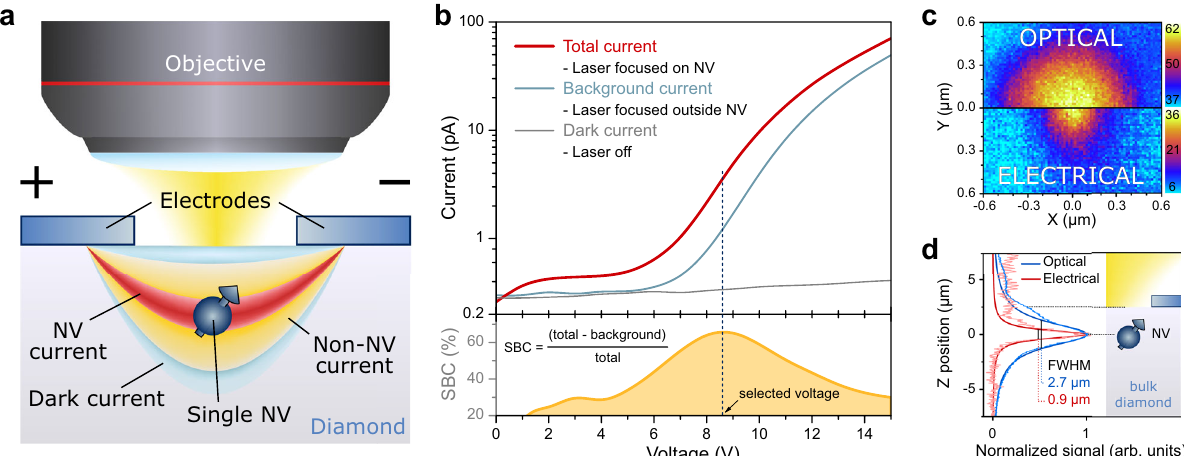
Fig. 1 Electrical detection of single NV centre. a Schematic of the PDMR chip with the single NV centre used for the measurements. A yellow-green 561 nm laser is focused between the contacts (with an inter-electrode distance of 3.5 µ m) using a microscope objective in air (N.A. = 0.95). The resulting currents are measured versus the bias voltage applied to the electrodes. We identify three types of currents: dark current — not related to the laser illumination, non-NV photocurrent — laser-induced photocurrent not originating from the NV centre, NV photocurrent — current from the two-photon ionization of the single NV centre. b Current – voltage characteristic curves for laser off (grey, dark current), for laser (4 mW) focused away from the single NV centre (cyan, background current from dark current and non-NV photocurrent) and for laser (4 mW) focused on the single NV centre (red, total current from dark current, non-NV photocurrent, and NV photocurrent). The bias voltage for the photocurrent measurements was set to 8.6 V as determined from the maximum signal-to-background contrast (SBC) calculated from the background and total current (dark yellow). c , d Simultaneous optical and electrical imaging of the single NV centre (laser power 6 mW). c XY map showing the size comparison of the same NV centre for the two detection methods. d Z scan of the NV. Darker curves are the Lorentzian fi ts of the experimental data points, FWHM stands for full width at half maximum calculated from the fi tted